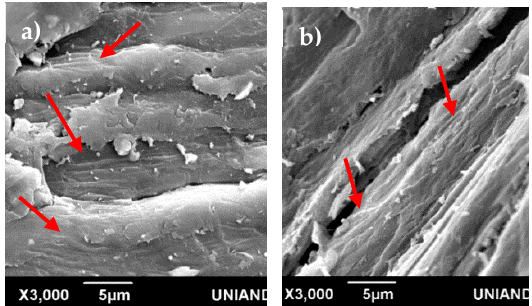
Figure 6. Scanning electron microscopy images of the fiber surface of the ( a ) barkless and ( b ) crushed samples after Ca(OH) 2 treatment.